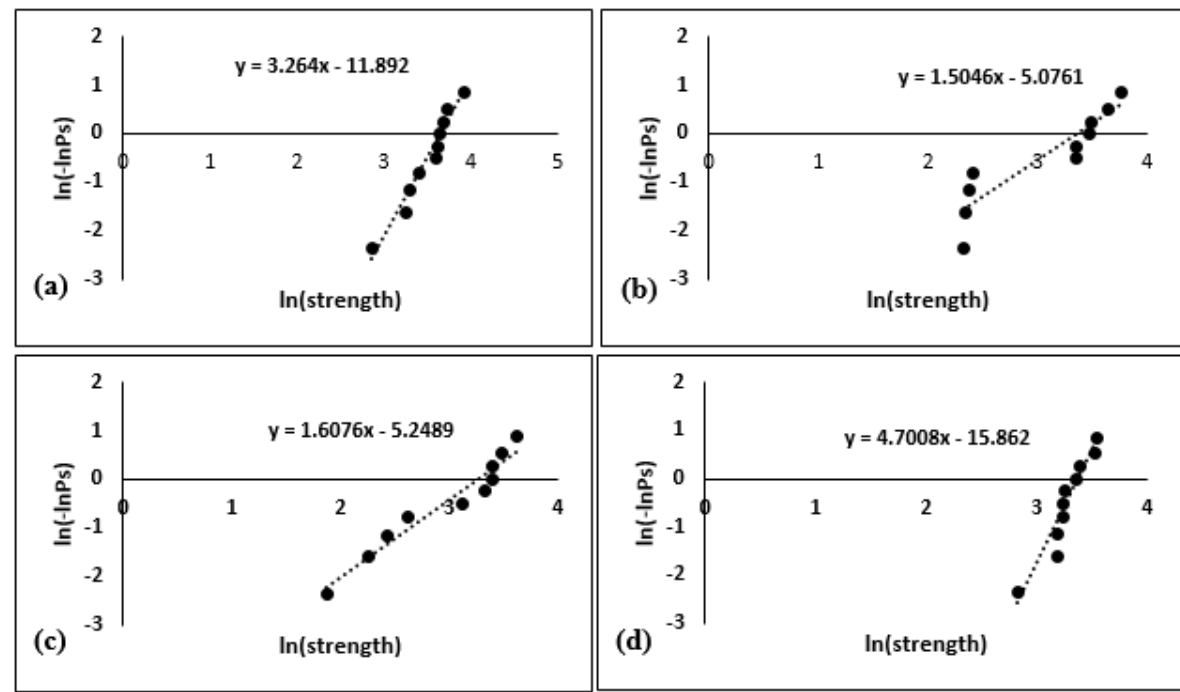
Figure 1: Weibull Distribution by piston-on-three-ball test (a) 1 wt% Al 2 O 3 , (b) 2 wt% Al 2 O 3 , (c) 3 wt% Al 2 O 3 , (d) 4 wt% Al 2 O 3